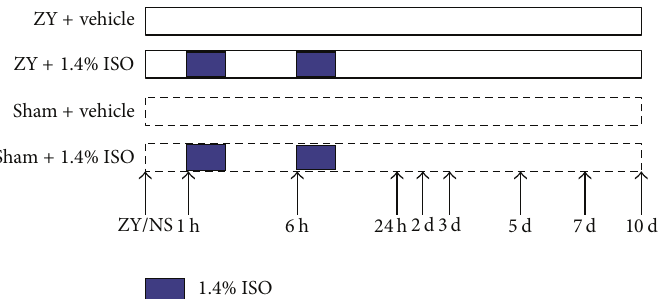
Figure 1: Schematic diagram of the experimental design. The animals were randomly divided into four groups ( 𝑛 = 20 per group): ZY + vehicle, ZY + 1.4% ISO, sham + vehicle, and sham + 1.4% ISO. ISO treatment was performed in the ZY + 1.4% ISO and sham + 1.4% ISO groups, with the animals exposed to 1.4% ISO for 1h starting at 1 and 6 h after ZY or NS injection, respectively. To serve as controls, animals in the sham + vehicle and ZY + vehicle groups were exposed to RA at the same time points. About 24h after ZY or NS injection, ZY-induced lung damage was observed and assessed in mice. The survival rate was monitored 1, 2, 3, 5, 7, and 10 days after ZY or NS administration.